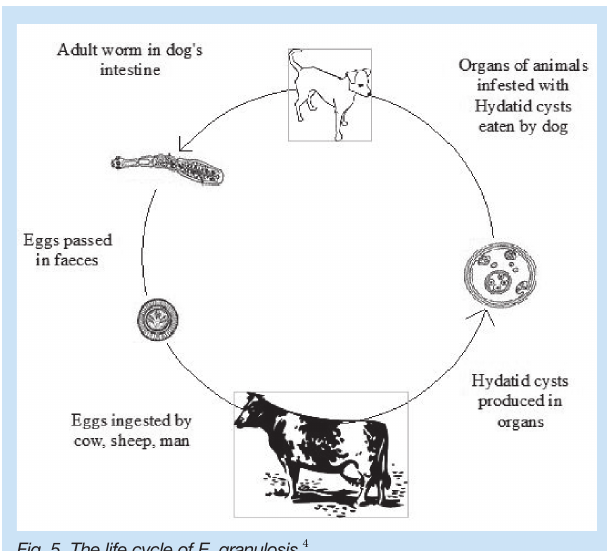
Fig. 5. The life cycle of E. granulosis. 4